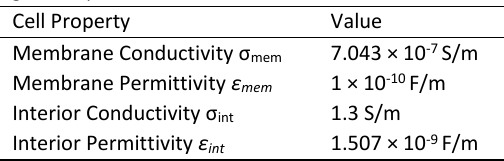
Table 2: the best results for cell properties obtained from genetic